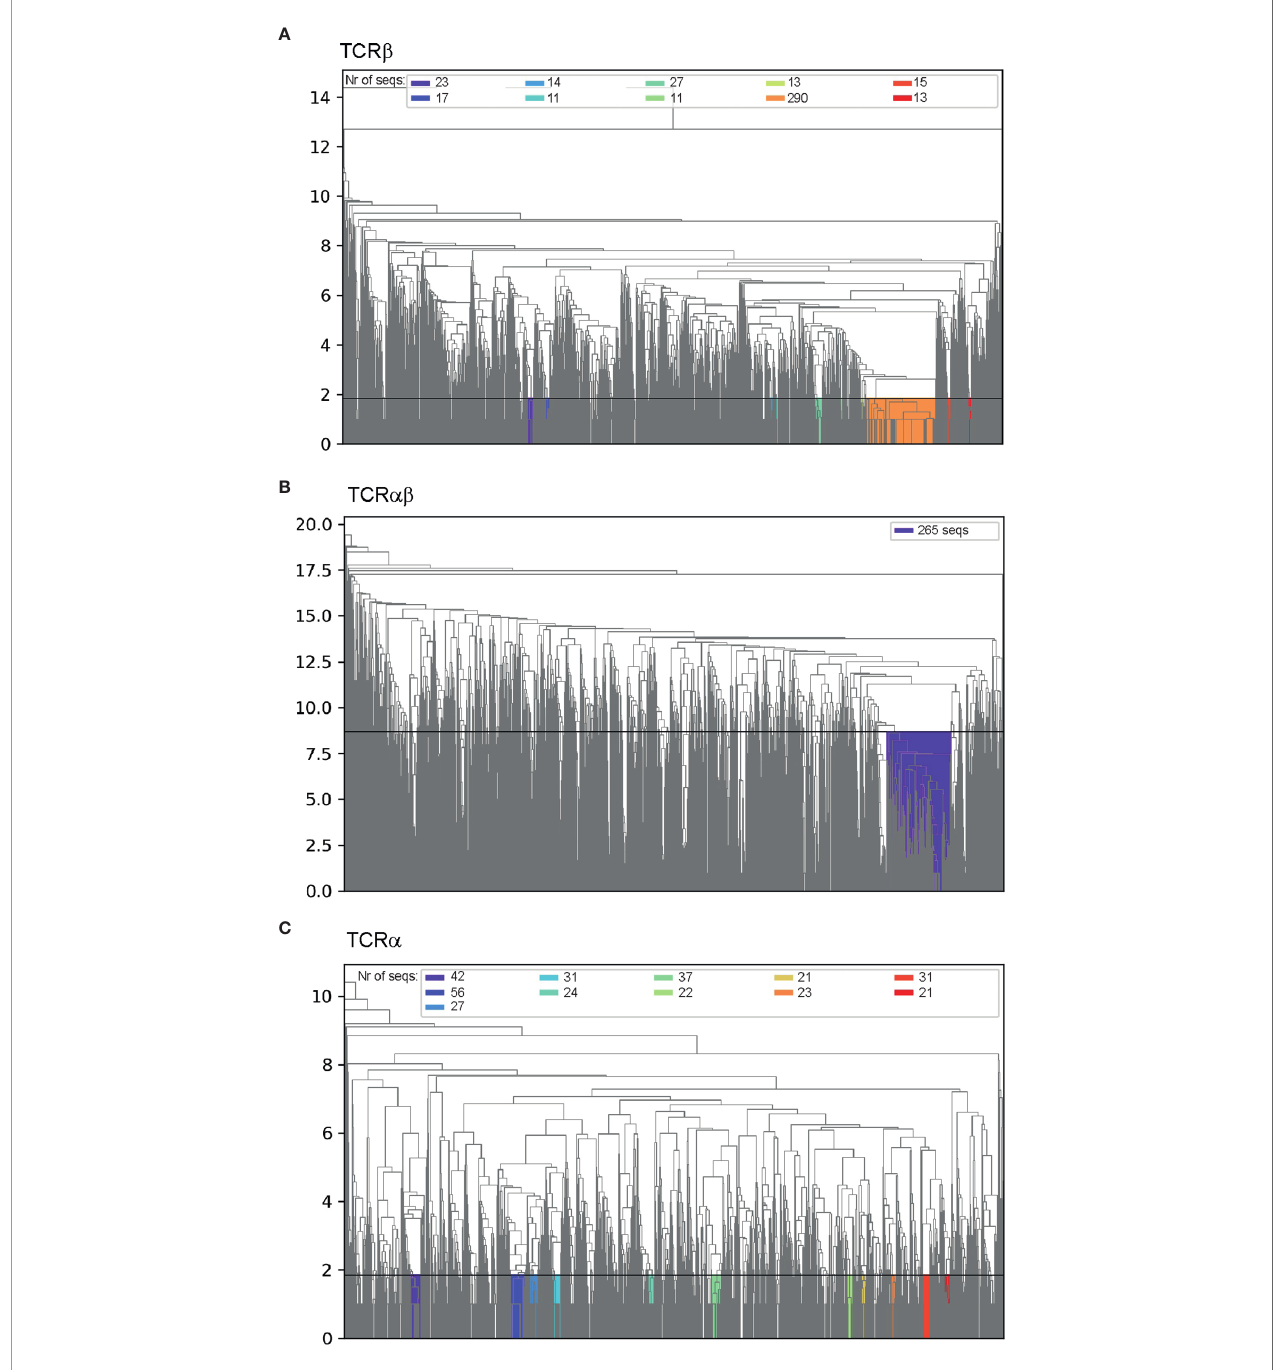
FIGURE 2 | Hierarchical clustering of (A) CDR3 b sequences, (B) paired CDR3 a :CDR3 b sequences and (C) CDR3 a sequences. The y-axis indicates the Levenshtein distance and the horizontal line shows distance that was used to cut the dendogram tree to generate the clusters. The clusters are colored and the respective number of sequences in each cluster are indicated in the